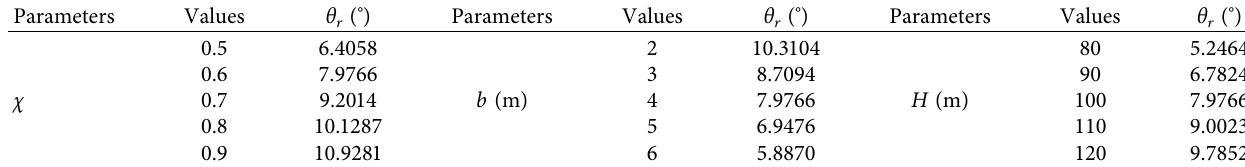
Figure 9: Convergence curves of the safety factor of stability of the rock slope facing the Tehran-Chalus Road obtained using different methods. Table 5: Sensibility analyses of the geometrical parameters of the slate slope in South